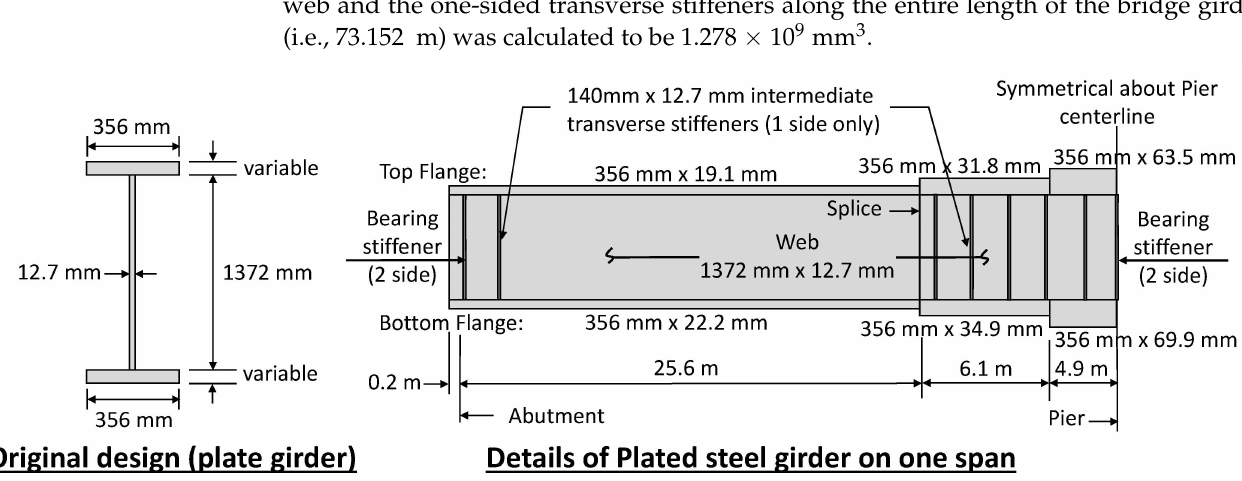
Figure 16. The final design of the plated steel girder on one span of the bridge.